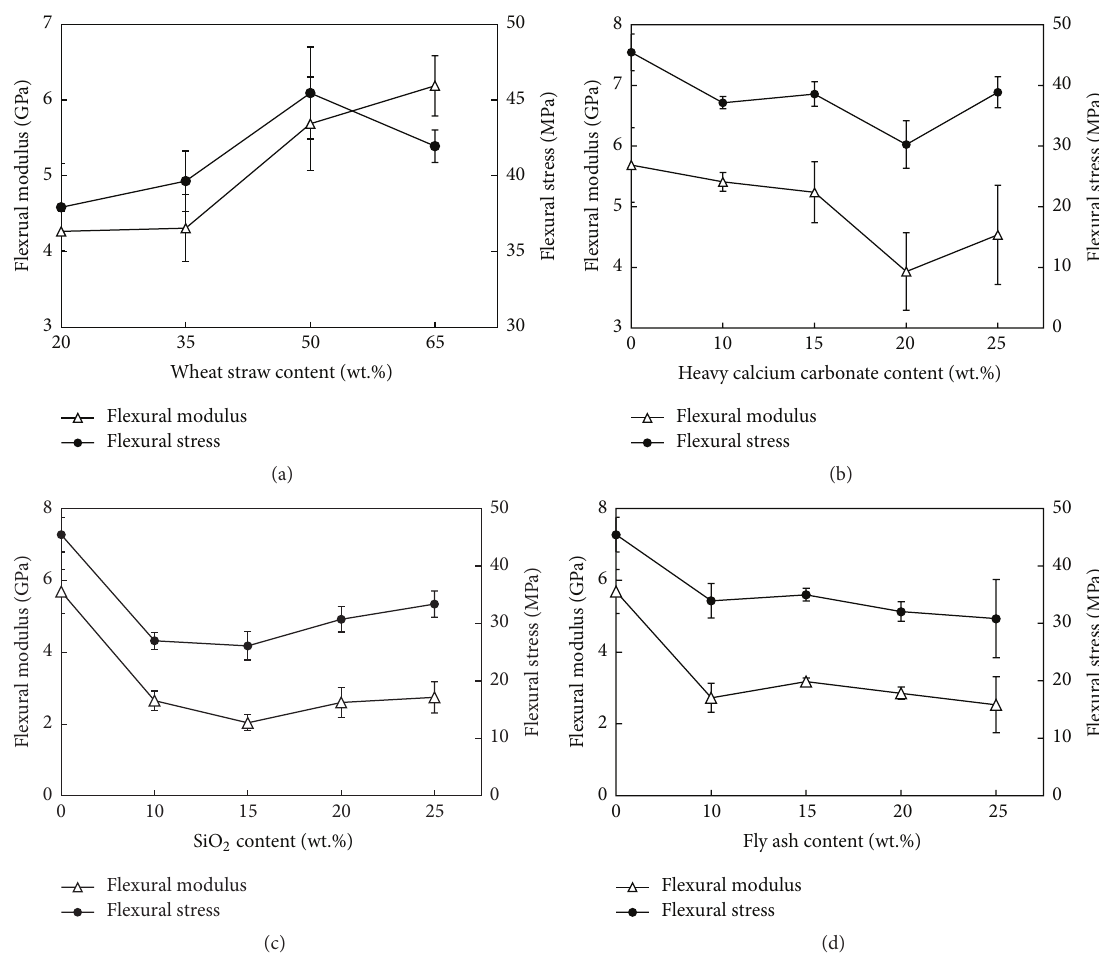
Figure2:FlexuralpropertyofWSfilledPPcomposites(a)andWSandinorganicfillerreinforcedPPcomposites,(b)heavycalciumcarbonate, (c) silicon dioxide, and (d) fly ash.